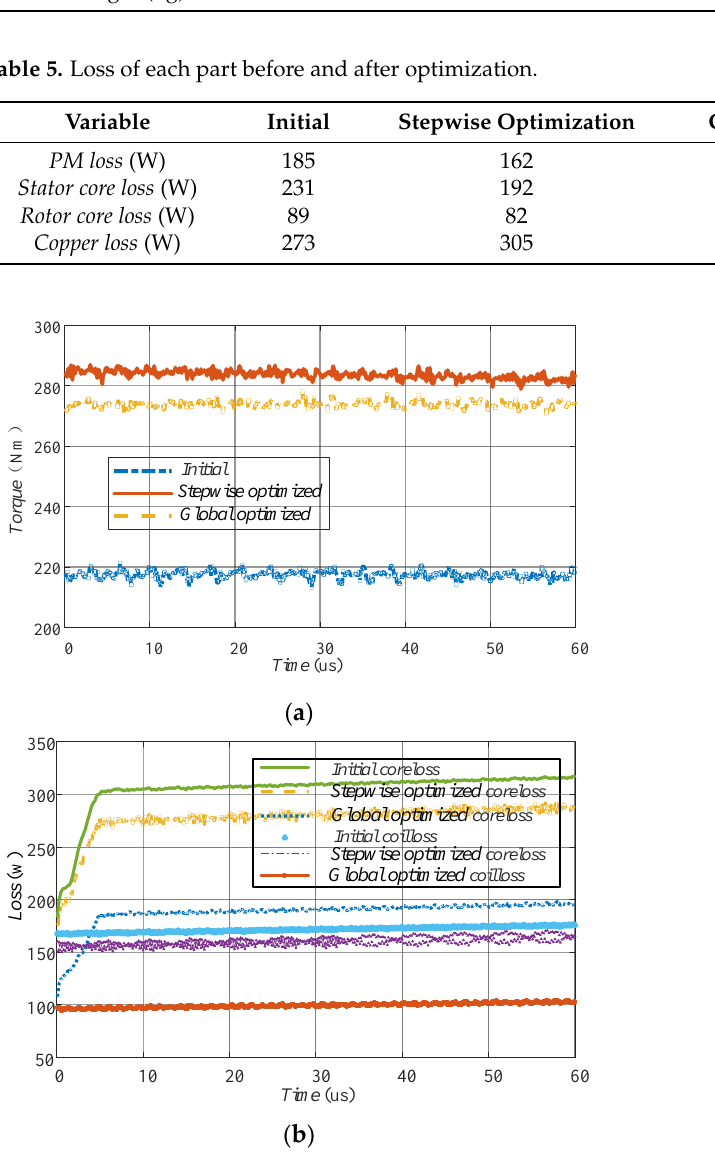
Table 4. Design parameters of the FSPM generator.